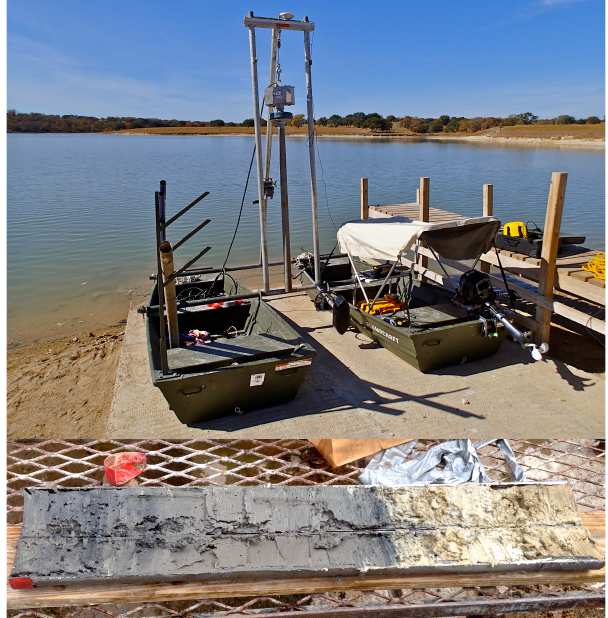
Figure 4. Reservoir sediment coring apparatus (top) and represen- tative sediment profile